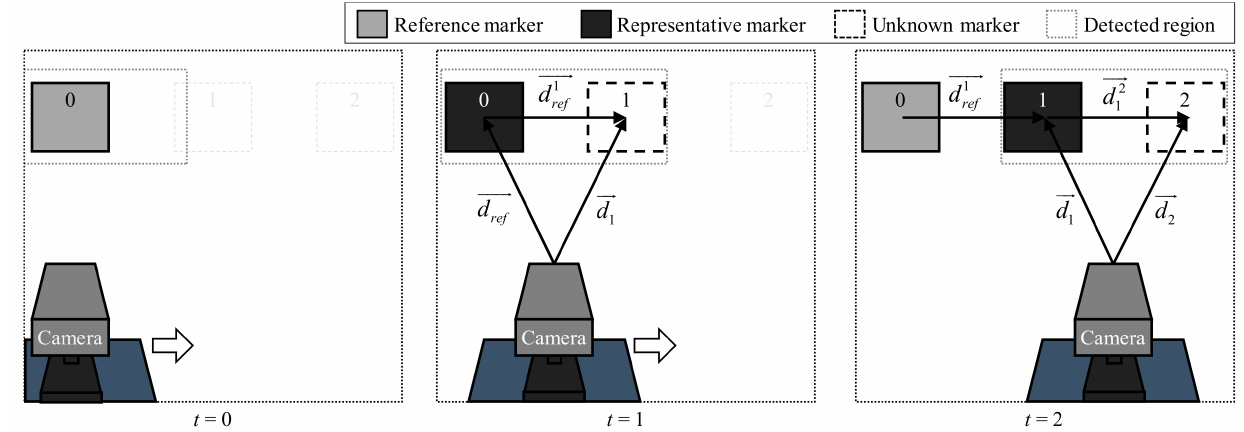
Figure 11. Process of calculating unknown marker